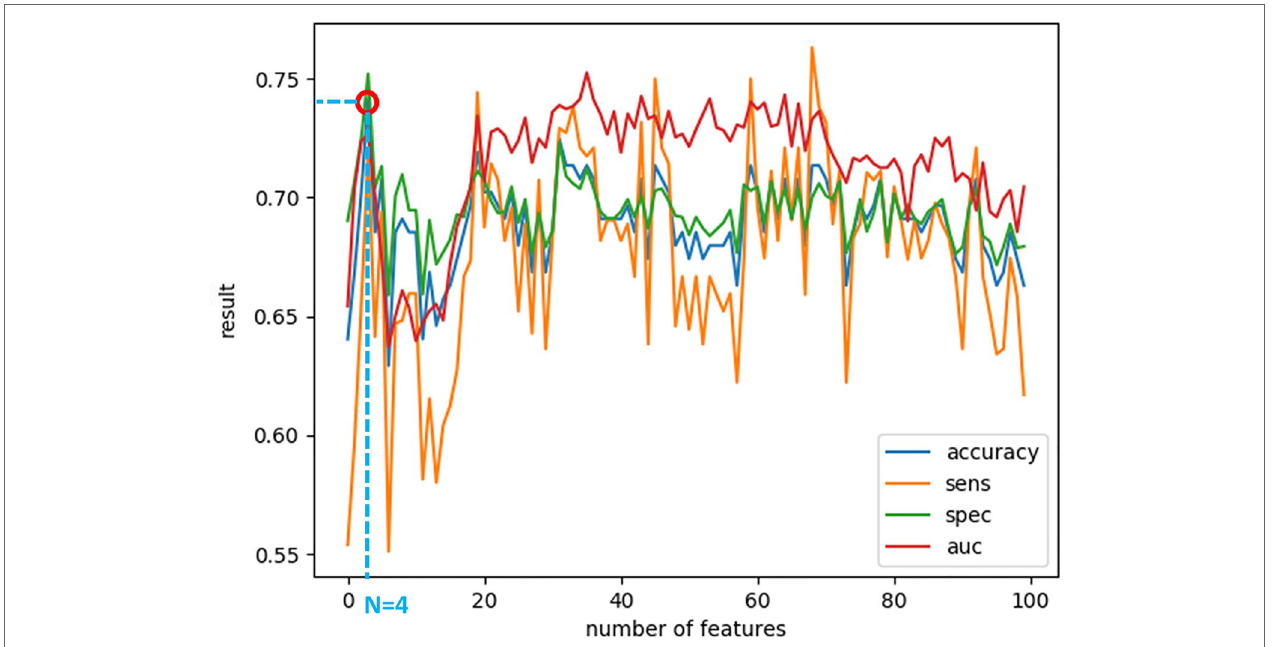
FIGURE 12 | The accuracy, sensitivity, specificity, and AUC obtained by changing the number of selected features for fMRI between 1 and 100 features. The maximum accuracy achieved is obtained when using four